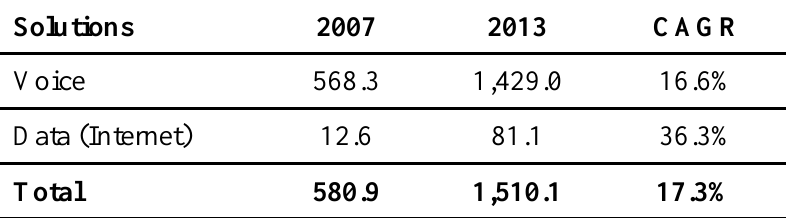
Note: All figures are in Mn USD; CAGR: 2007-2013 Source: Frost & Sullivan